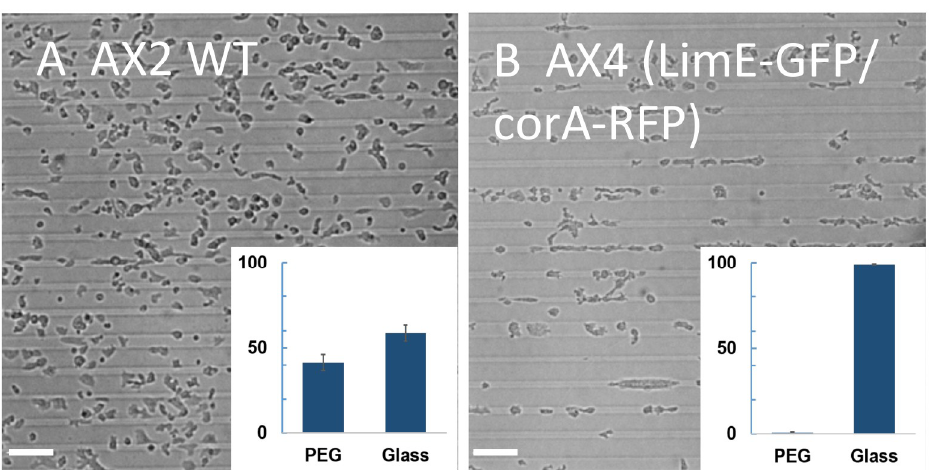
Fig 3. Developed cells on micropatterned substrates. Micrographs of WT AX2 cells (A) and AX4 cells expressing LimE-GFP and Coronin-RFP (B), 10 min after plating. Insets: relative coverage of cells on PEG-gel and glass stripes (expressed here and elsewhere as a percentage). Whereas AX2 cells adhere to PEG-gel and glass in comparable proportions, AX4 cells are found nearly exclusively on glass stripes. (Scale bar: 50 μm